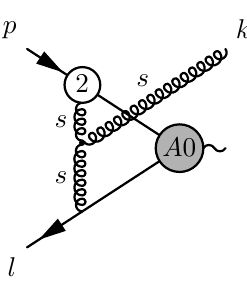
Figure 10 . The only diagram relevant to the one virtual, one-real contribution to the two-loop soft function. Here the power suppression is placed on the collinear leg as indicated by the